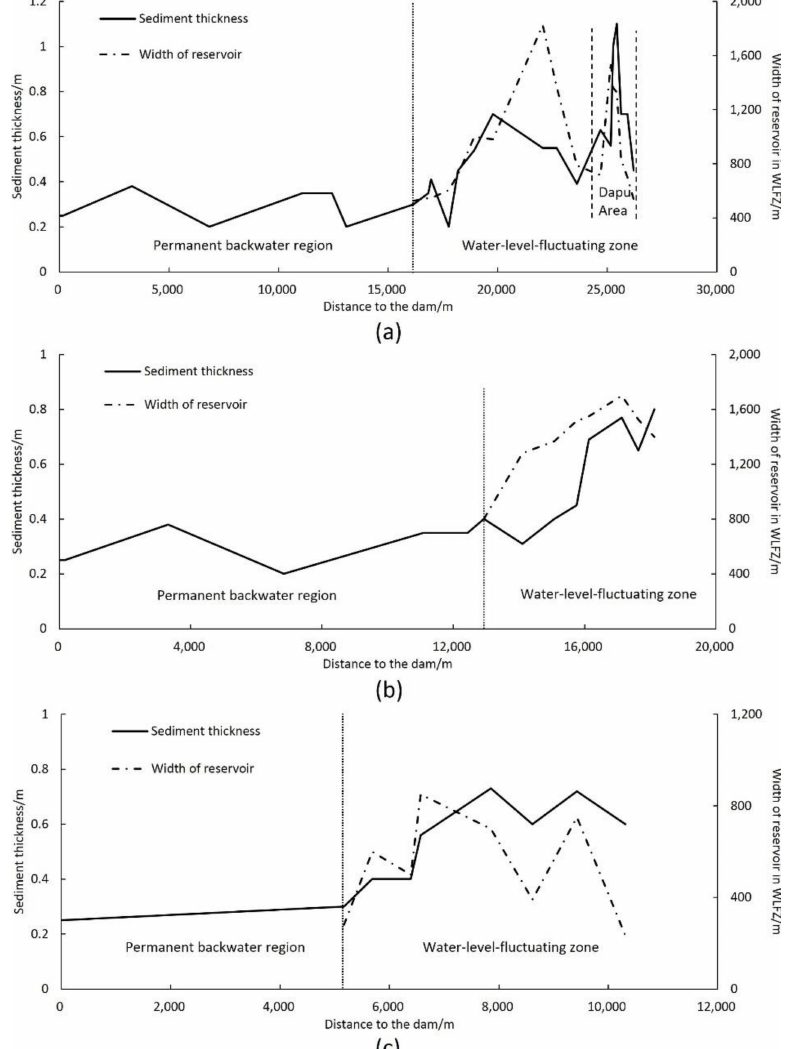
Figure 2. Sediment thicknesses and the width of the reservoir in the WLFZ along the thalwegs of: ( a ) the Biliu River, ( b ) the Geli River, and ( c ) the Bajia